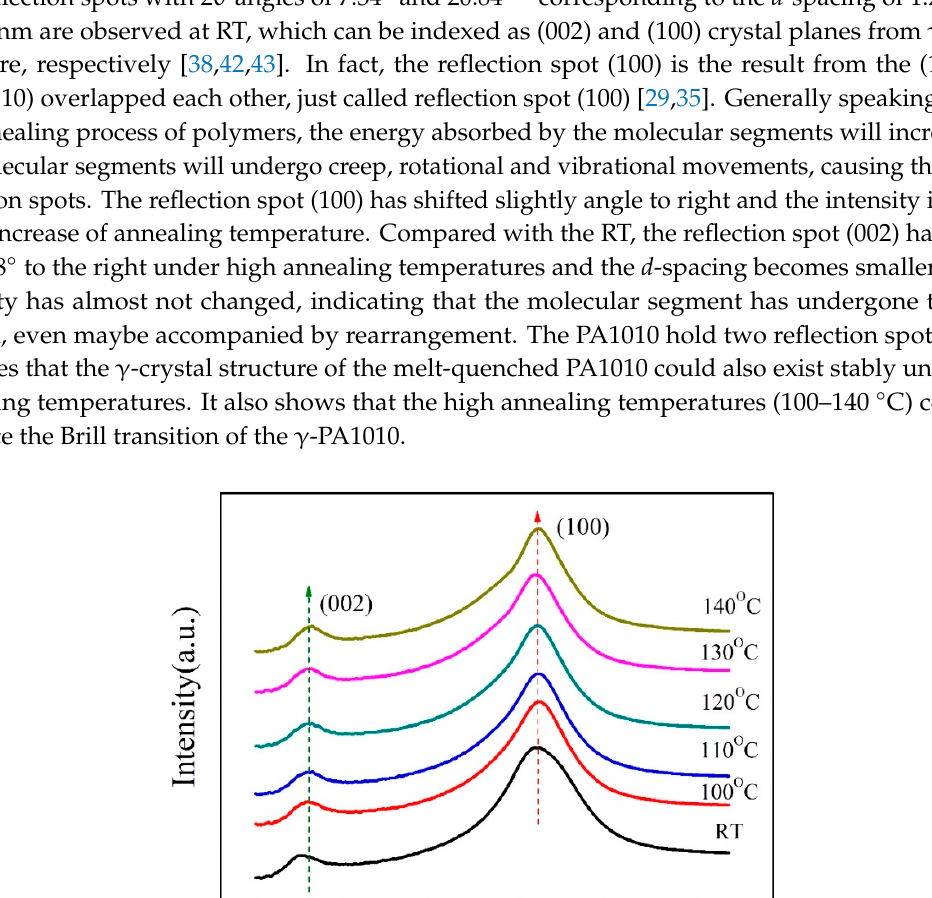
Figure 1. XRD patterns of PA1010 at different annealing temperature.